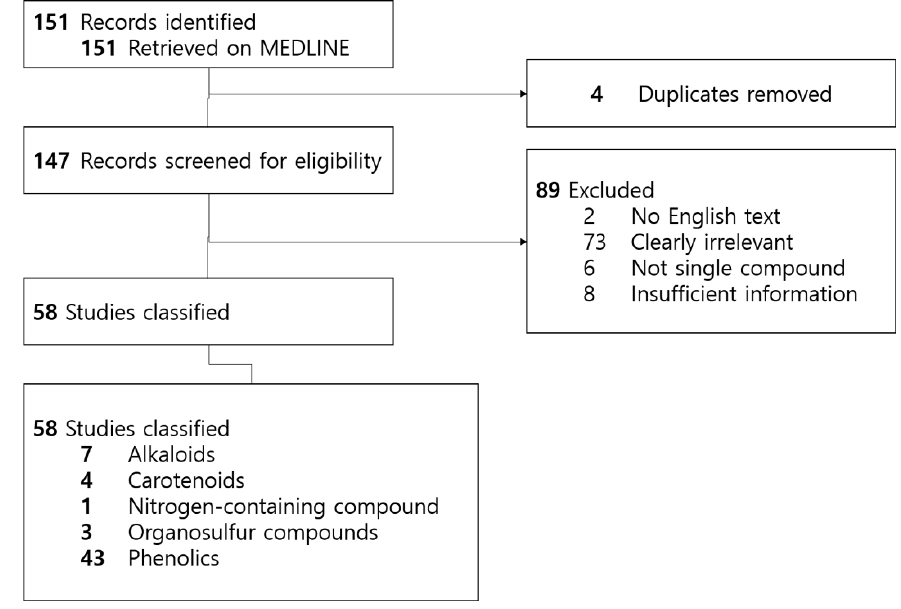
Figure 2. Review design flowchart.